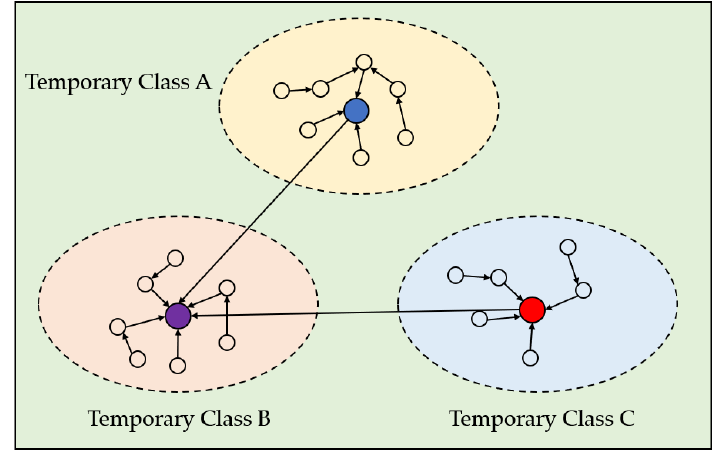
Figure 6. DAG-based temporary classes for the wireless sensor networks.